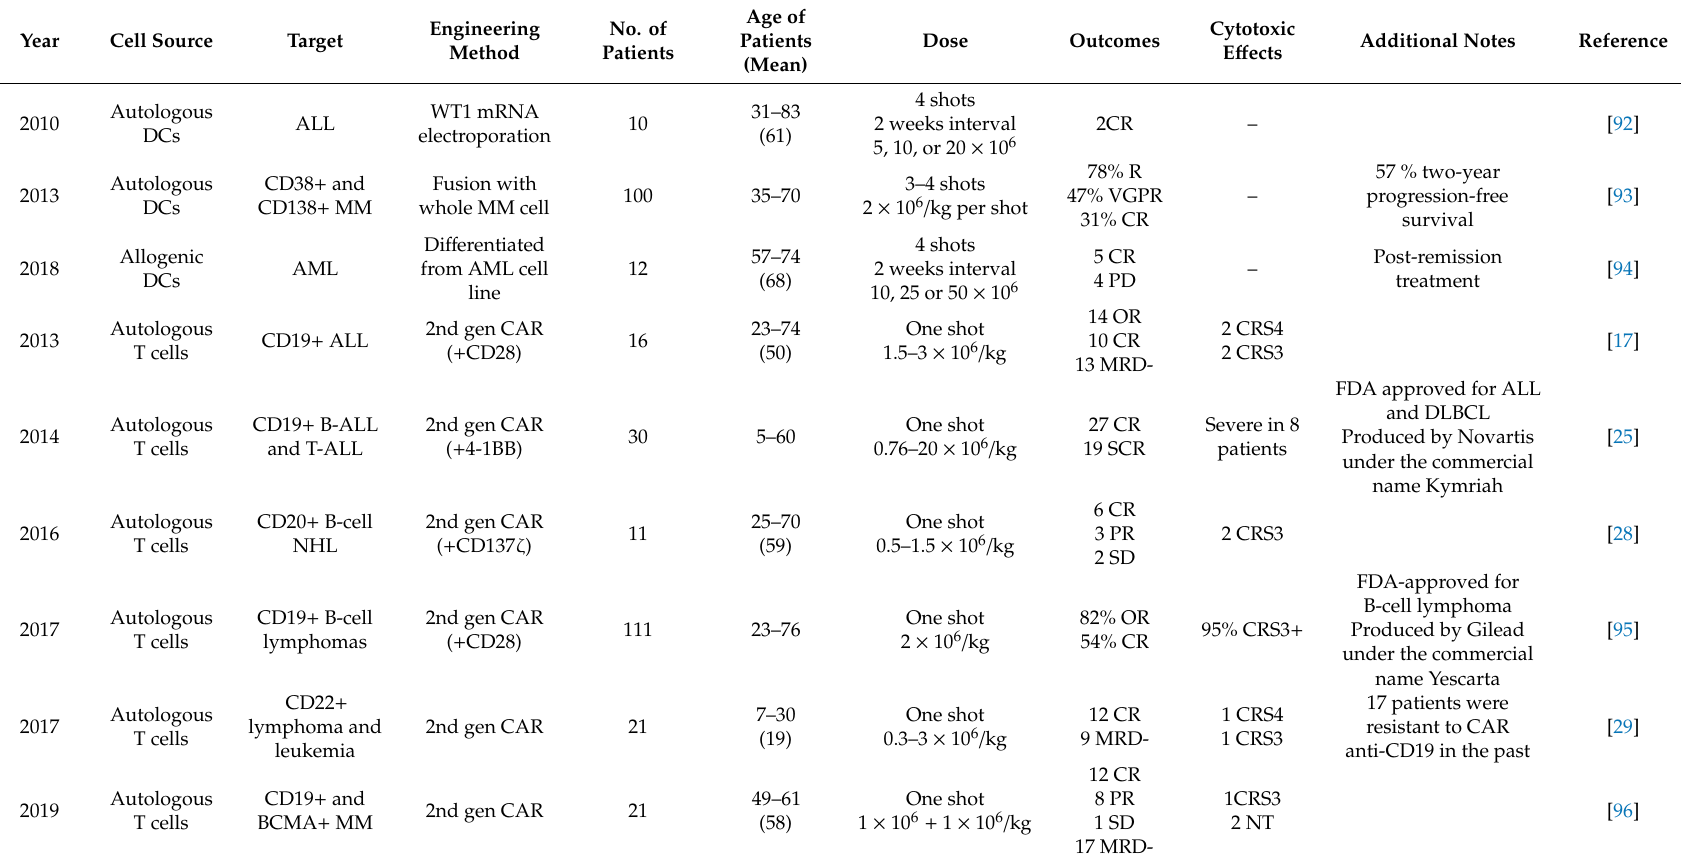
Table 1. Selected cell-based clinical trials with immune cells to treat hematological malignancies featuring key